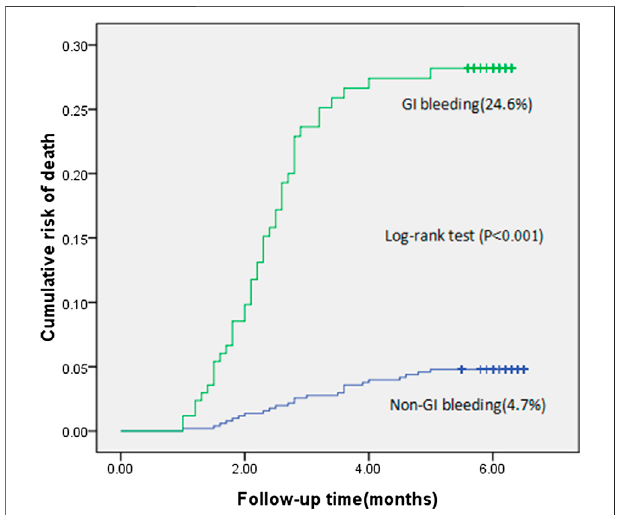
FIGURE 2 | Cumulative risk of death in patients with gastrointestinal bleeding compared with patients without gastrointestinal bleeding (the logrank test, p <